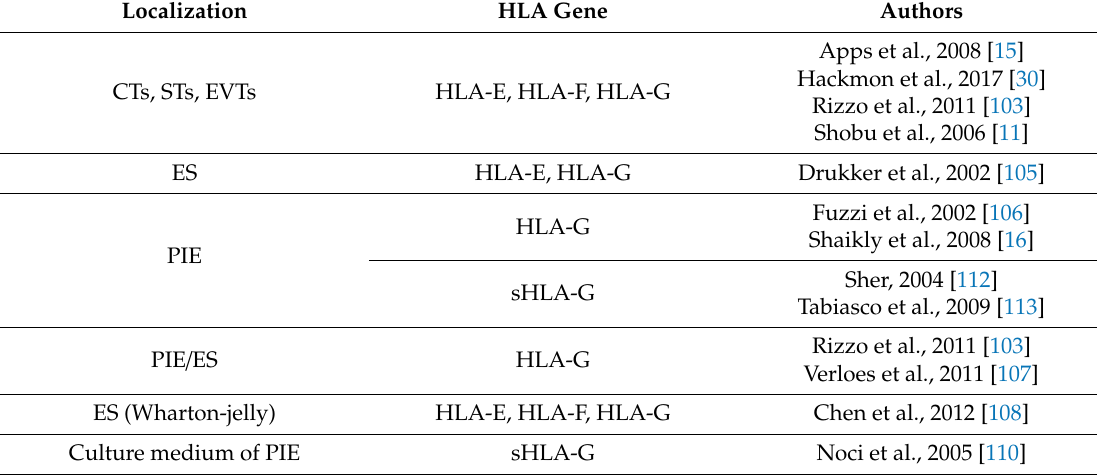
Table 1. Overview of proven occurrences of HLA groups E-G and their